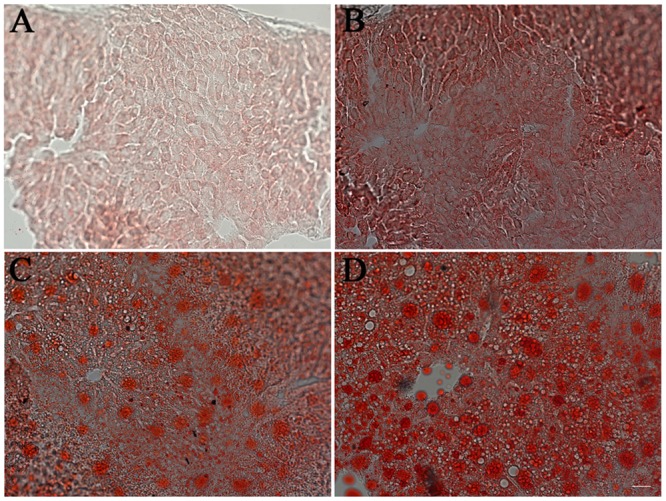
Effect of diet modification on lipid accumulation in the liver.Liver tissue slides were stained with oil red O and photographed under a microscope. Compared with control mice (A), lipid droplets could be detected obviously in the HFR mice (B), HFA mice (C) and HFF mice (D). The length of the scale is 20 μm.